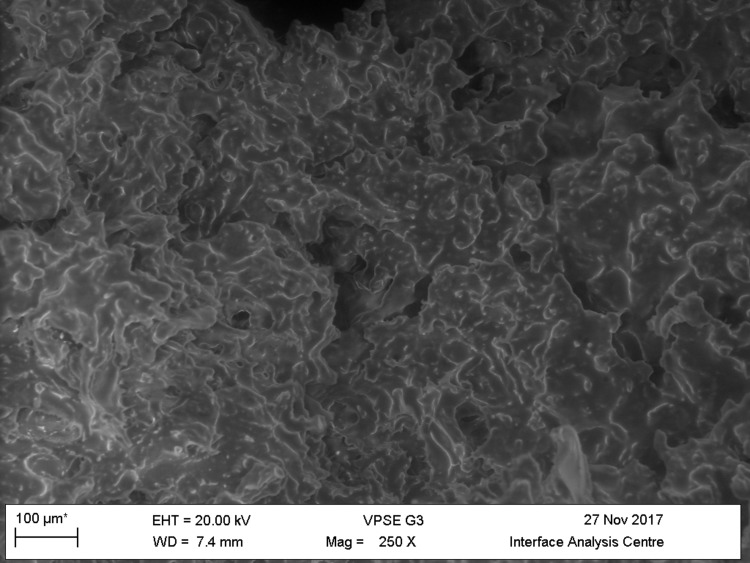
Demineralised modern chicken bone viewed at a distance.